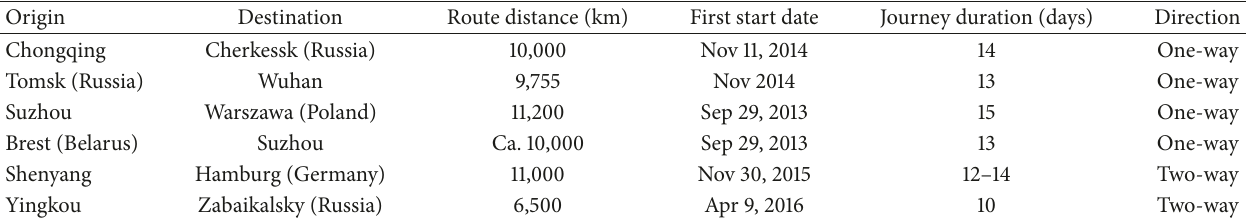
Table 2: Major “CR expresses” (via Manzhouli hub) (source: author, adapted from [1] and news from https://www.yidaiyilu.gov.cn/). Origin